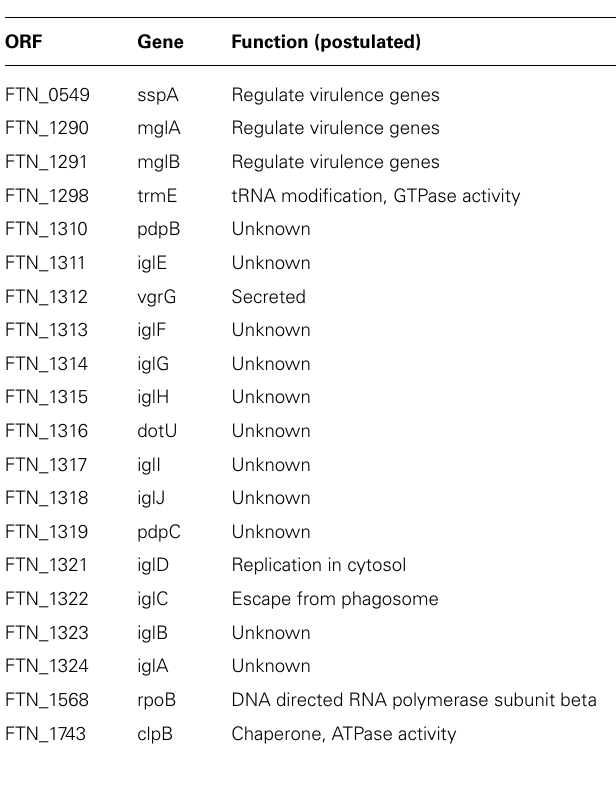
Table 1 | Genes required for Francisella induction of PGE2 synthesis in Francisella -infected